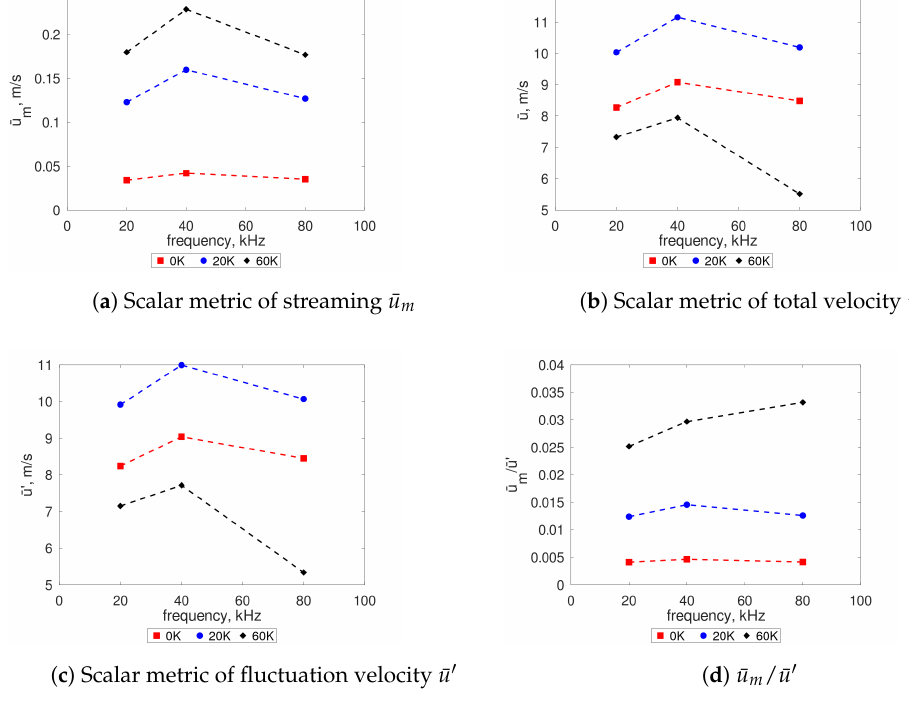
Figure 8. Changes of scalar metrics of: ( a ) streaming velocity ¯ u m ; ( b ) total velocity ¯ u ; ( c ) fluctuation velocity ¯ u (cid:48) ; ( d ) ratio of streaming velocity to fluctuation velocity ¯ u m / ¯ u (cid:48) , in the function of ∆ T and frequency f